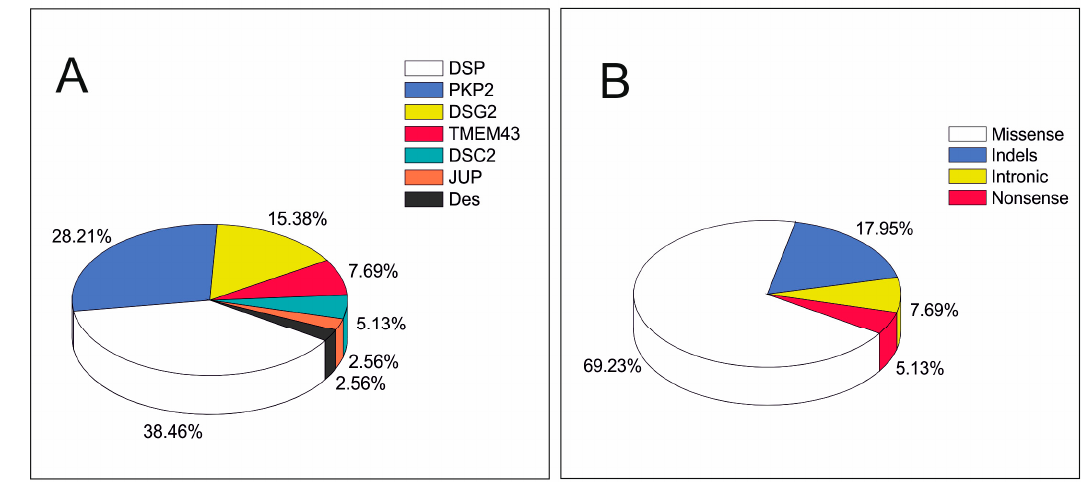
Figure 1. Rare variant distribution in genes and mutation types. ( A ) Localization of the 39 evaluated variants in arrhythmo- genic cardiomyopathy (ACM)-causal genes. ( B ) Distribution of mutation types of the 39 evaluated variants.